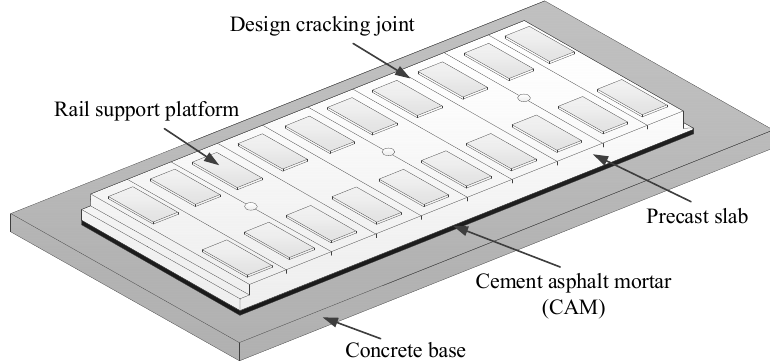
Figure 19. CRTS-II slab track system components before longitudinal connection.